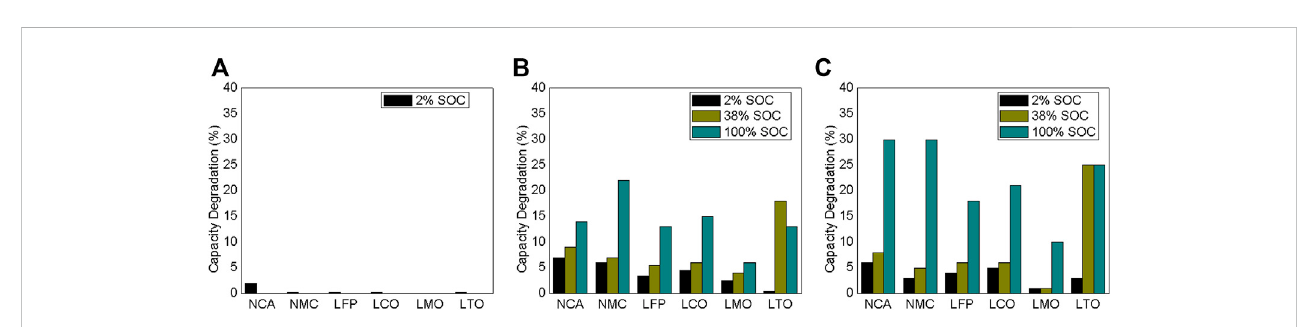
FIGURE 2 Capacity degradation of six chemistries over 120 days at storage temperature (A) 18.5 ° C, (B) 50 ° C, and (C) 60 °